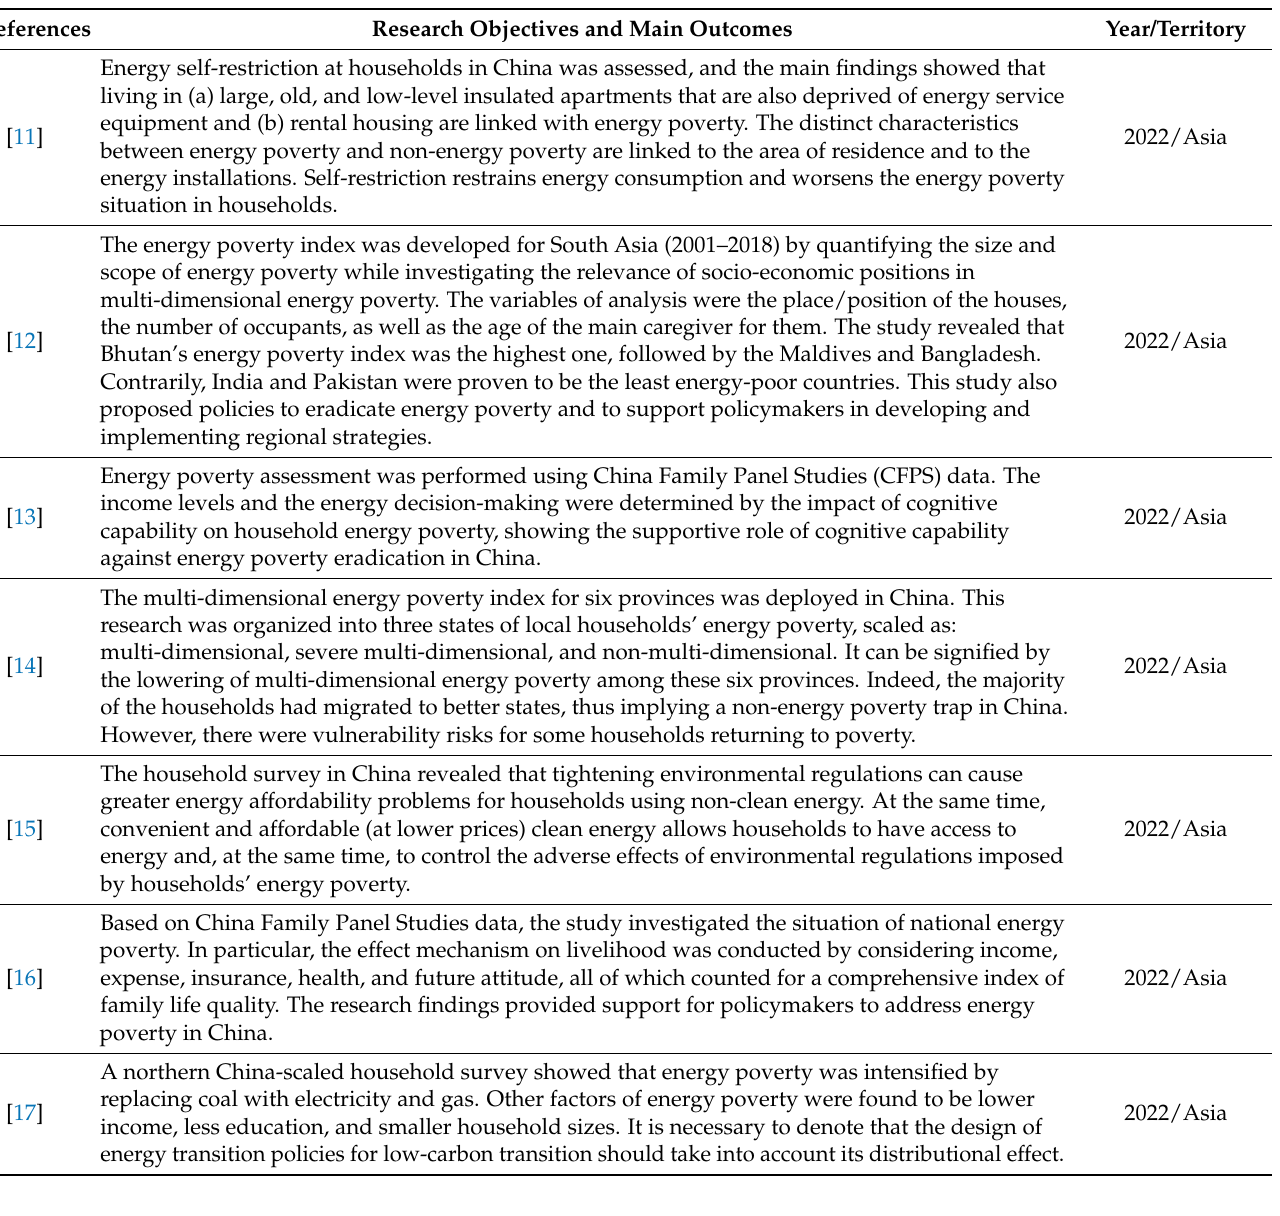
Table 2. Allocation of research studies on energy poverty globally (Source: Authors own